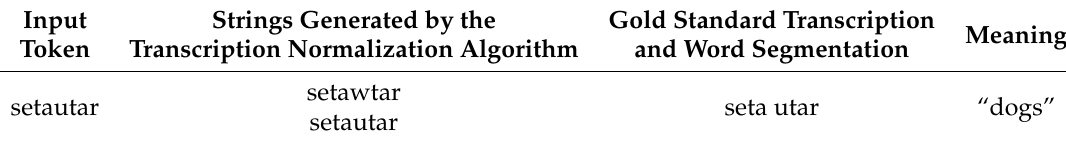
Table 4. Example of a situation where the transcription change rules should not be